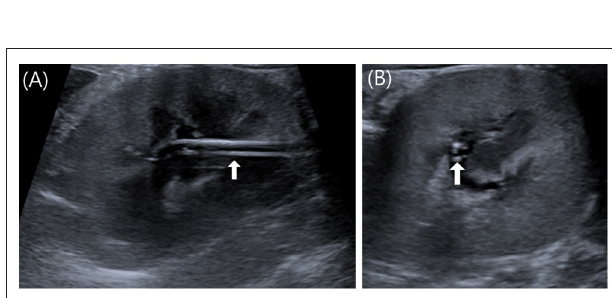
FIGURE 4 | Postoperative US images of left kidney. (A) Sagittal image. (B) Transverse image. Three days after surgery, the left renal pelvic height was observed to be within 2mm on US, and a nephrostomy tube was observed normally as two parallel lines in the renal pelvis (white